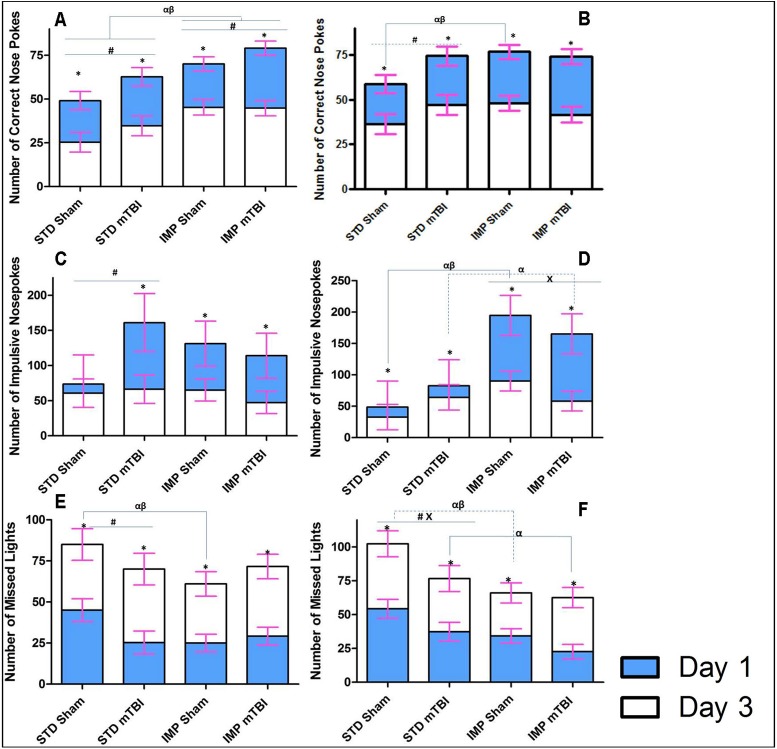
Illustrative representation of the results from the extinction portion of the behavioural testing for STD and IMP animals; blue bars represent the initial testing day and white bars represent the scores after the 3rd consecutive day of no reward in the 5 choice serial reaction task.In this task, rats are no longer rewarded for completing the task as previously trained; therefore learning would entail switching strategies and reducing the number of correct nose pokes. The upper panels (A & B) demonstrate the number of correct lights with STD-shams learning the task quicker; the middle panels (C & D) show that the average number of impulsive nose-pokes (premature or inappropriate) decreased when the reward was removed; and finally (E & F) represent the number of lights that the rats chose to ignore with STD-shams again outperforming all other groups (α significant effect of IMP at Day 1, β significant effect of IMP at Day 3, x significant effect of mTBI, * significant effect of testing period, all p < .05).